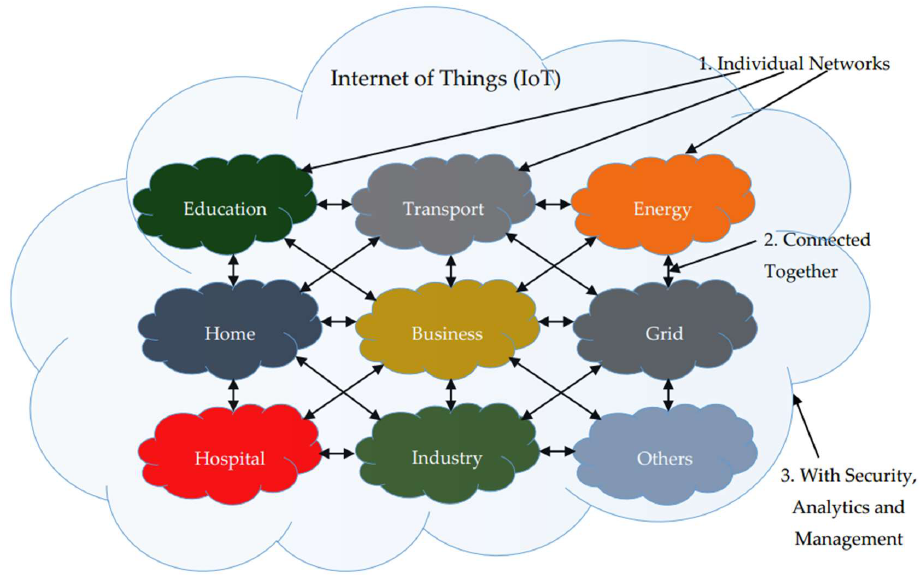
Figure 1. IoT can be viewed as a Network of Networks. Adapted from [5].